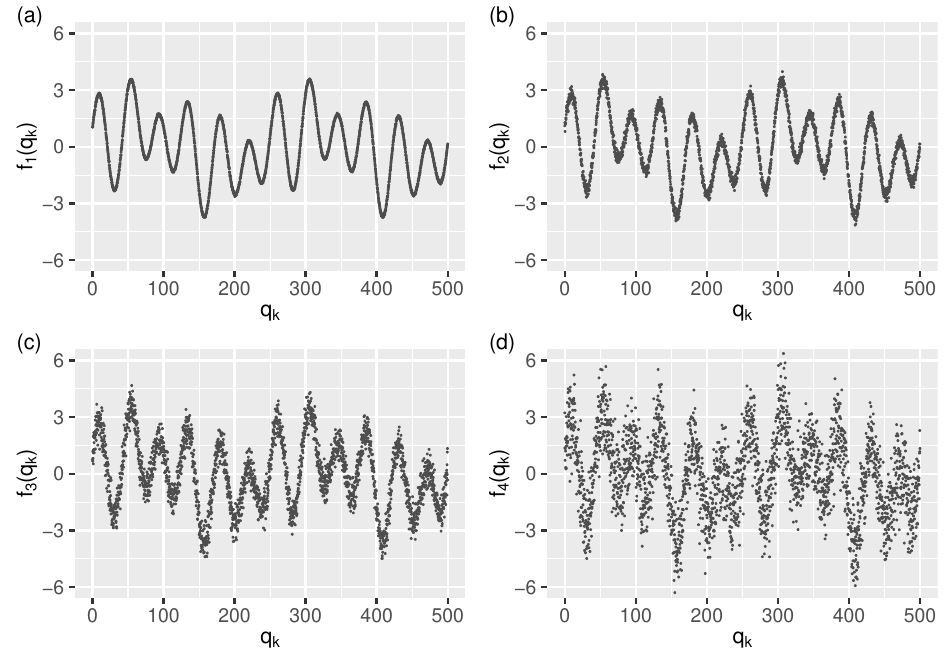
Figure 2. Signal g (Equation (2), for readability shown only in the interval [ 0,500 ] ) used—after discretization and adding Gaussian noise—to generate the test streams used in the evaluation of the proposed algorithm.